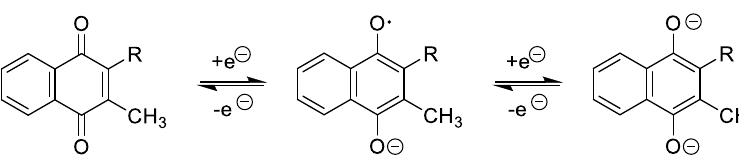
Figure 2. The redox reaction of menaquinones showing the two steps observed in aprotic organic solvent; in the presence of a protic solvent it occurs in only one step, but the overall reaction is